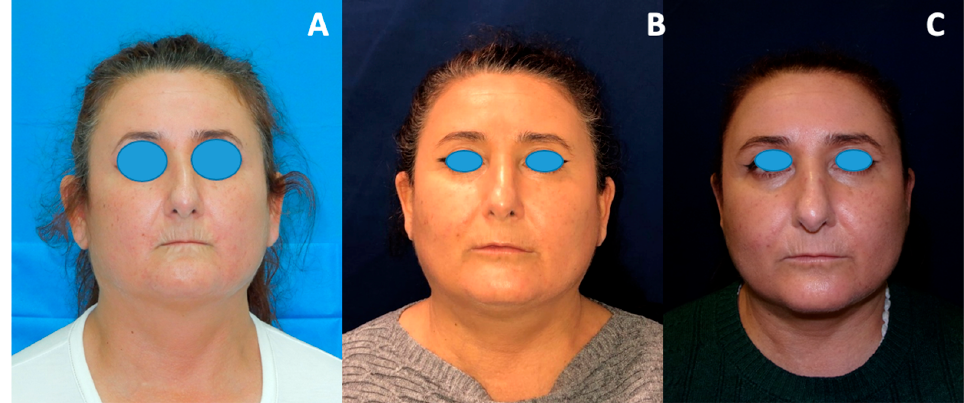
Figure 4. Preoperative ( A ), 6 months postoperative ( B ), 1 year postoperative ( C ).